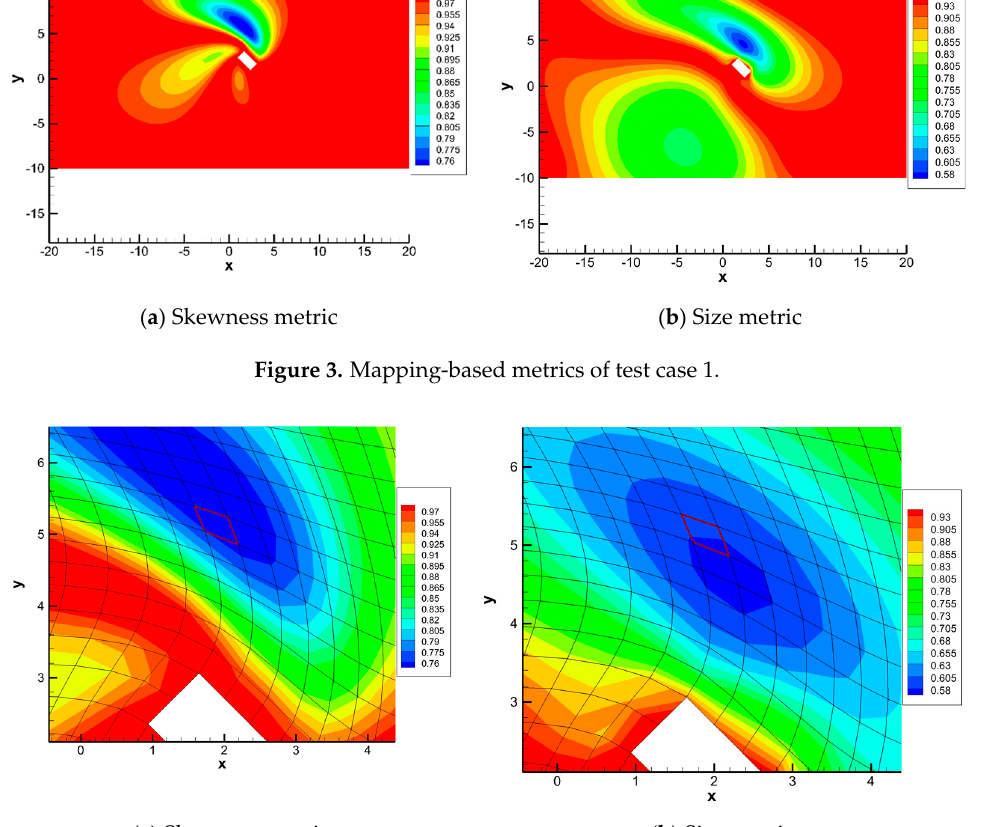
Figure 4. Specific element with minimal metrics.